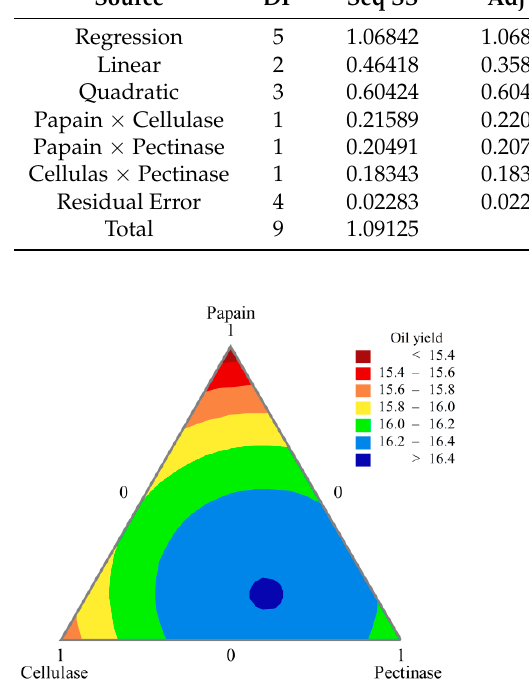
Figure 4. Hybrid contour line plot of oil yield (%). Table 5. ANOVA results of the enzyme mixture designs.